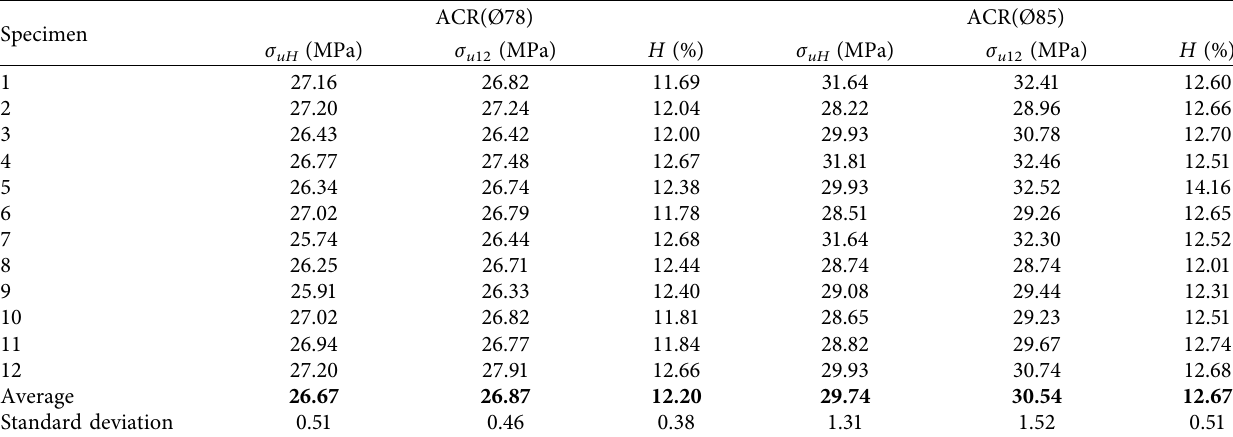
Table 7: Failure stresses in radial compression, diameter 78cm and 85cm.